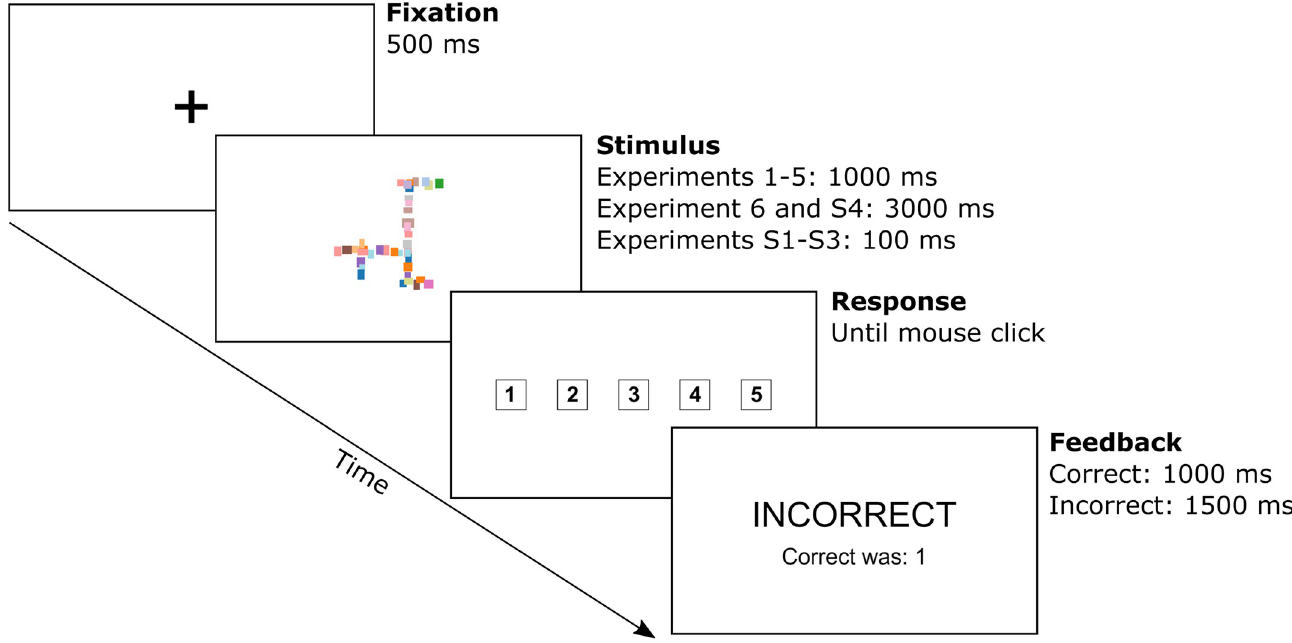
Fig 7. Procedure for human experiments. Time course for a single training trial in human experiments. The test trials followed an identical procedure, except participants were not given any feedback on their choices.